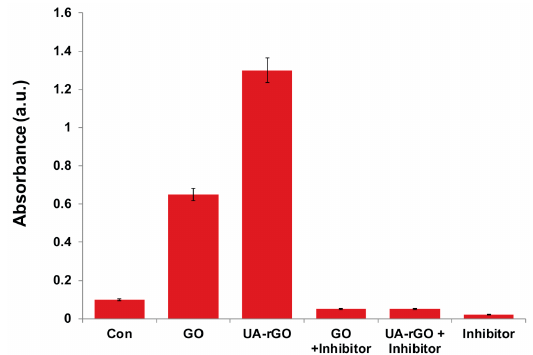
Figure 10. GO and UA-rGO induce ROS generation in human ovarian cancer cells. Relative fluorescence of 2 ′ ,7 ′ -dichlorofluorescein was measured at the excitation of 485 nm and emission of 530 nm using a spectrofluorometer. The results are expressed as the mean ± standard deviation of three independent experiments. The treated groups showed statistically significant differences from the control group by the Student’s t -test ( p < 0.05).